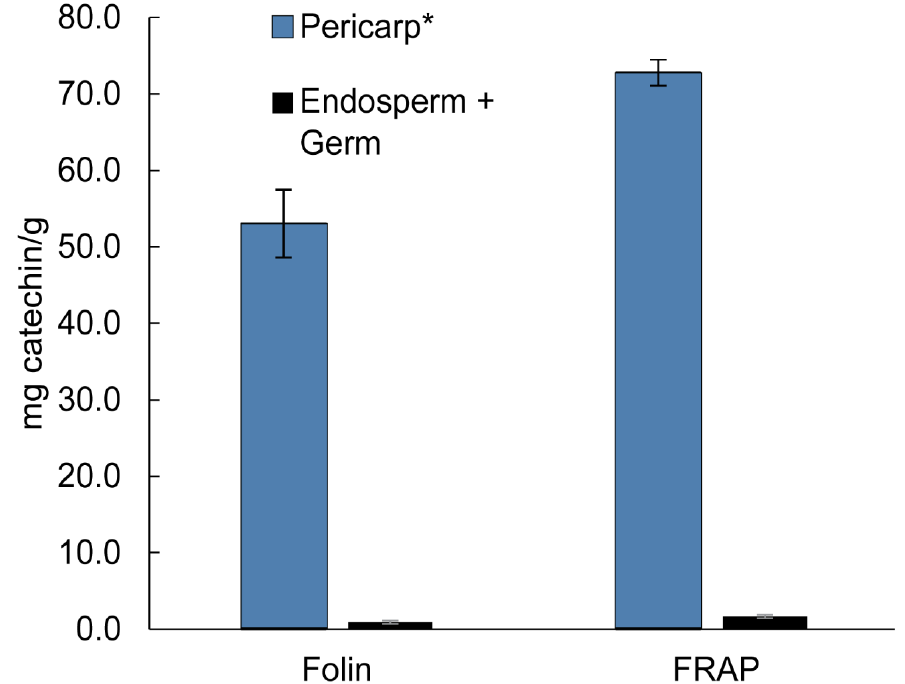
Figure 2. Average total phenolic content (Folin) and antioxidant capacity (FRAP) of the popcorn pericarp and endosperm + germ. *Significantly more phenolic acids are present in the pericarp versus the endosperm (n = 9, p < 0.05).